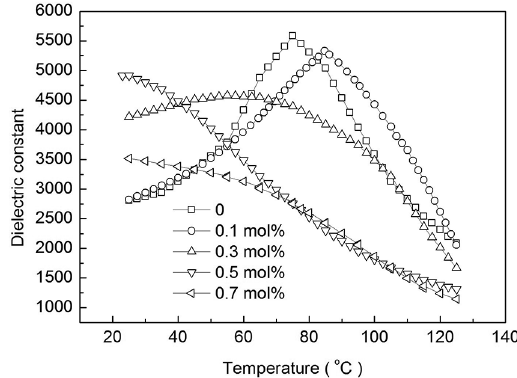
Figure 8: Temperature dependence of dielectric constant of BZT10 + x Yb O ceramics sintered at 1300 o C/2 h 2 3